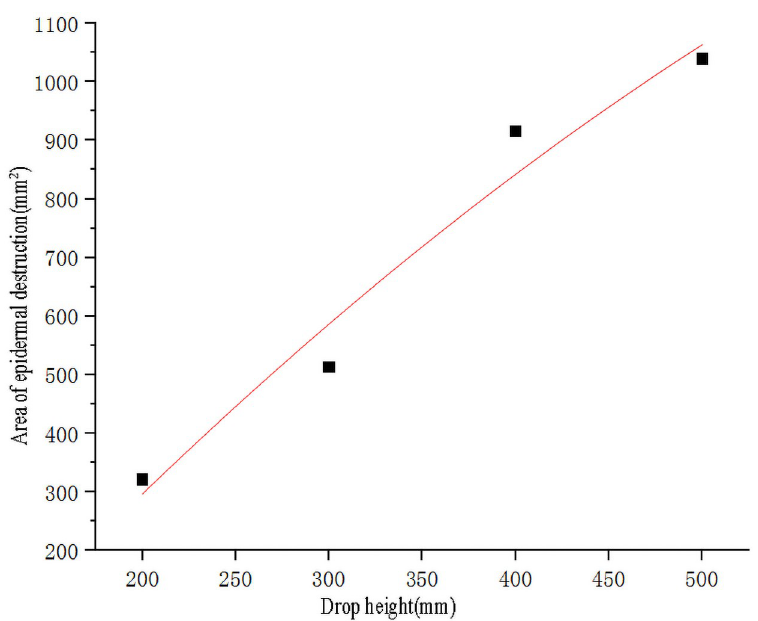
Fig 8. Fitting curve of sweet potato drop height and the area of epidermal destruction. Note: 1 Goodness of Fit refers to the degree to which the regression curve fits the observed values. The statistic that measures goodness of fit is the coefficient of determination R 2 . The maximum value of R 2 is 1. The closer R 2 is to 1, the better the fitting degree of the regression line to the observed value is. Use SPSS software to fit the curve of sweet potato drop height and data (Table 3) of the area of epidermal destruction (Fig 8). The points used for the fitting are to eliminate the test points with zero epidermal destruction area. The fitting obtains the quadratic curve equation as shown in Eq (9), the goodness of fit R 2 = 0.96 1 , and compared with we tried other forms of fit- ting equations, the goodness of fit of Eq 9 was closest to 1, so it had the best fitting effect. Substituting the broken skin area Y = 0 into the formula (9) to obtain the effective root, the 1 critical epidermal destruction height of sweet potato is h = 108.28mm. 1 ð 9 Þ